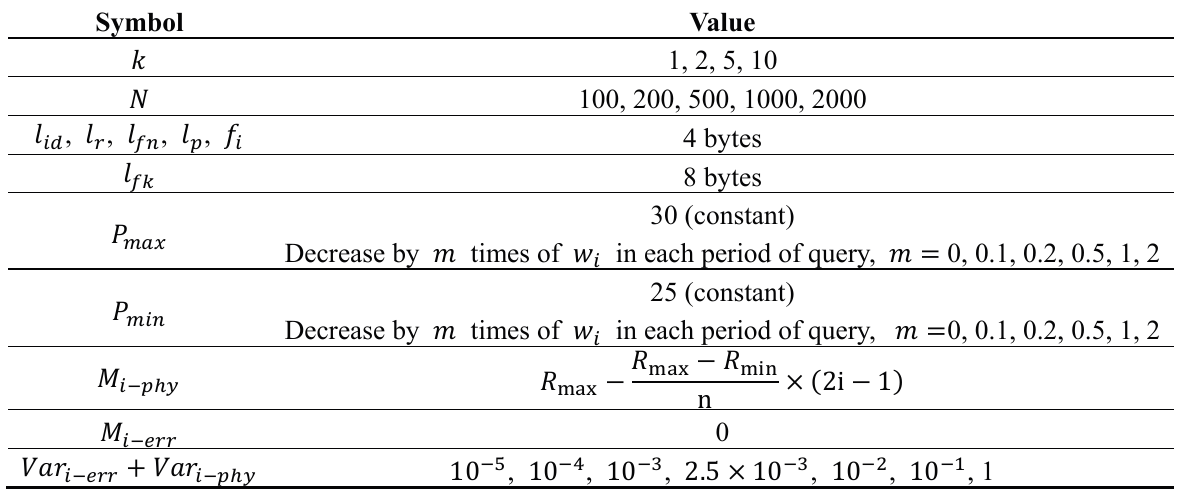
Table 3. Instantiation of